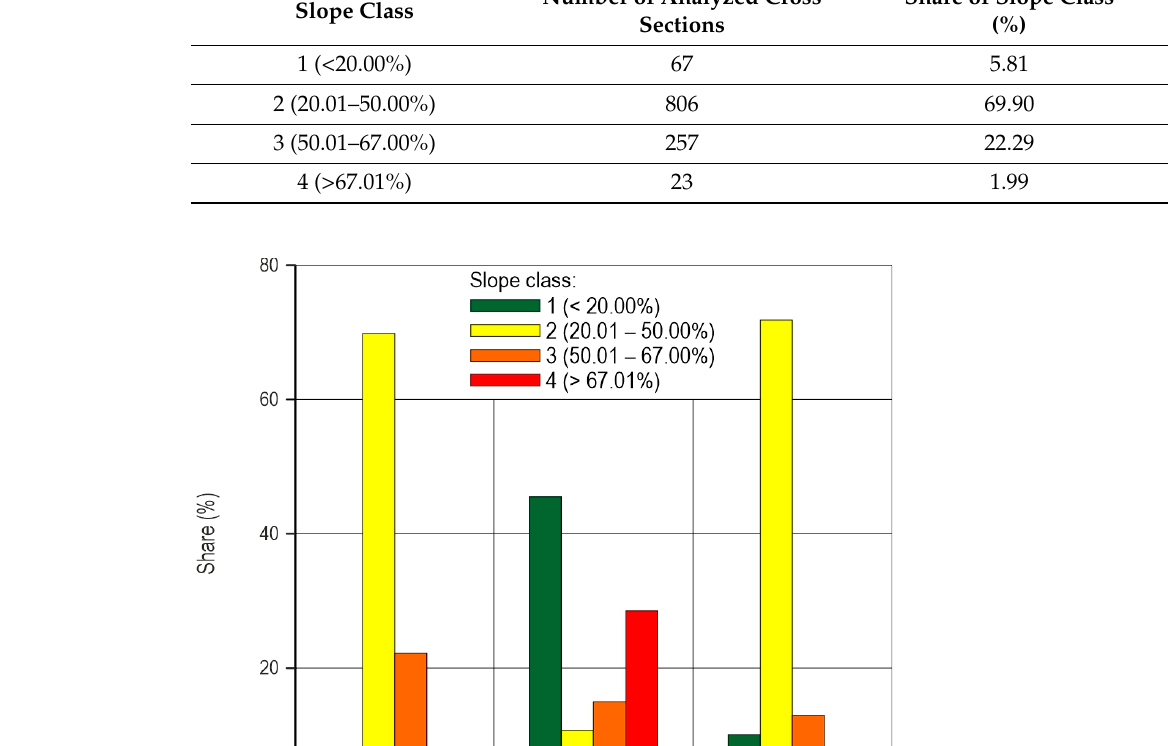
Table 3. Share of analyzed profiles by slope classes.